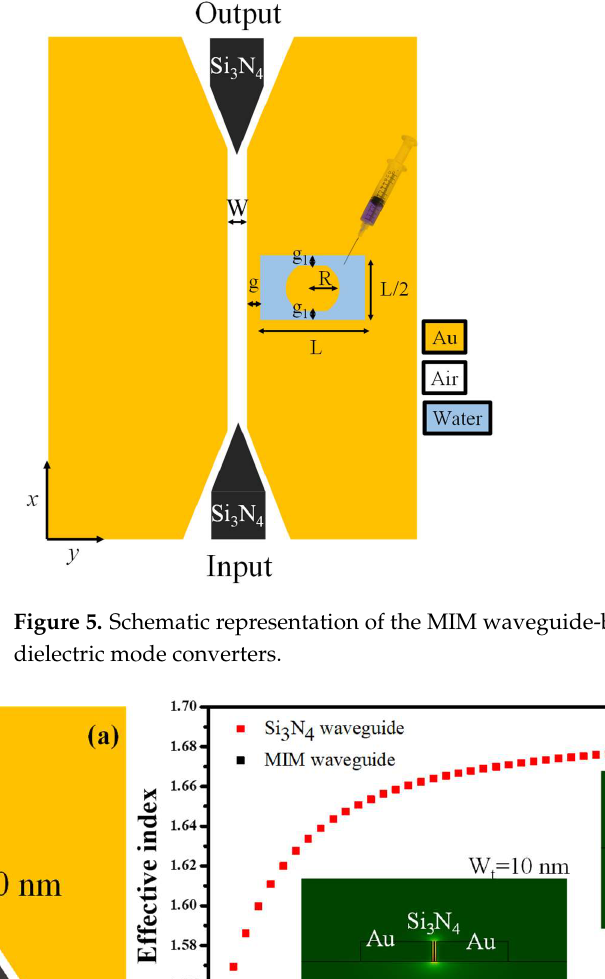
Figure 7. H-field distribution in the plasmonic sensor system at, ( a ) on-resonance state, ( b ) off-reso- nance state. 6. Conclusions In this paper, a plasmonic sensor based on a MIM waveguide is proposed and nu- merically analyzed via the finite element method for the detection of tuberculosis (TB) infected blood plasma. The size and shape of the micro-cavity in the plasmonic resonant sensors are quite crucial in obtaining a sharp resonance dip. Therefore, we suggested a hollow rectangular cavity with a metallic island. This configuration provides a resonance